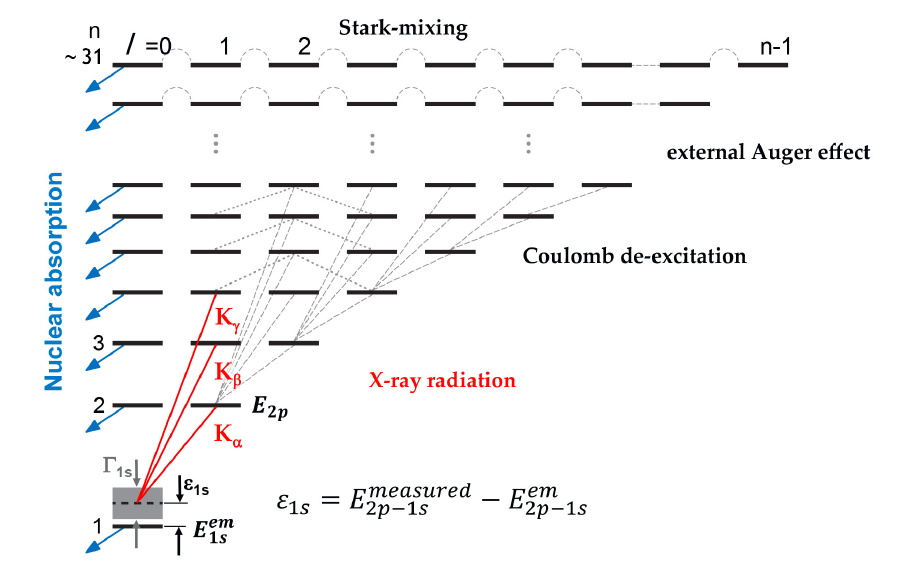
Figure 1: The kaonic hydrogen cascade process, which starts when the kaon is cap- tured in a highly excited state and lead it to the 1 s ground level. The fundamental state is shifted and broadened due to strong interaction. Adapted from [ 1 ]